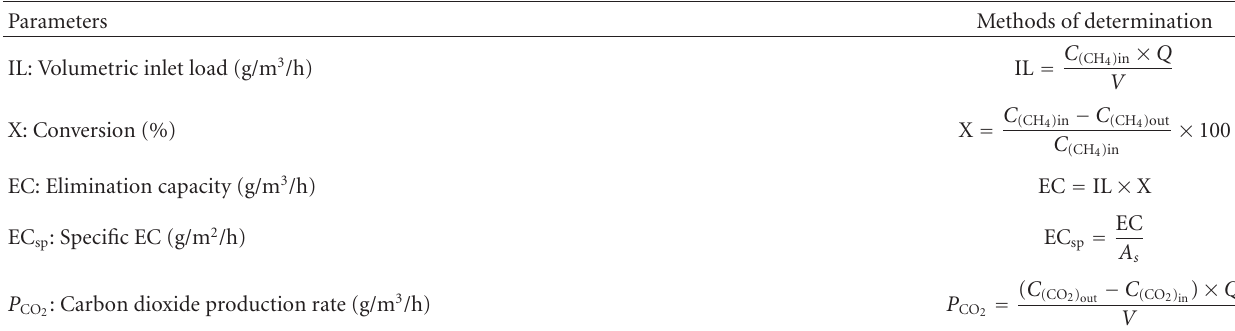
Table 2: Determination of the quantitative parameters.